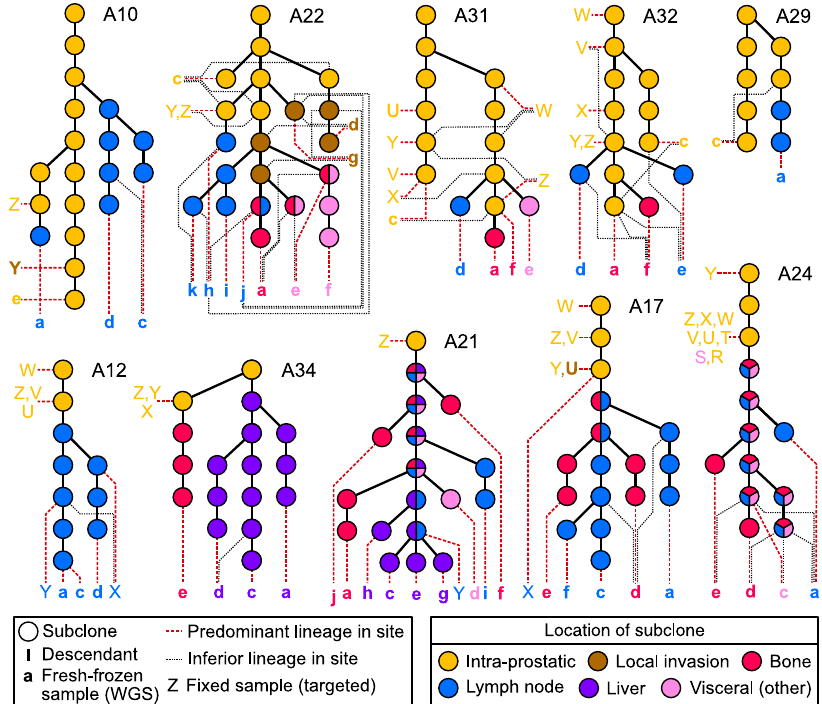
Fig. 1 Phylogenetic trees of primary and metastatic prostate cancer evolution in ten men. Top row — patients who still had prostate in place at time of death; bottom row — patients who had undergone radical prostatectomy (A12, A17, A21, A24) or had no discernible cancer in the prostate at time of death (A34). Patient identi fi ers are to the right of the root node of each tree, which represents the most recent common ancestor (MRCA) of all tumor cells. Dotted lines connect the fi nal subclone of a lineage with a letter denoting the sample or samples in which it was observed. Samples connected to multiple lines arising from different subclones indicates subclonal intermixture in the prostate and local organs, or polyclonal seeding in the periphery. Yellow fi lled subclones were observed in samples taken from the prostate. Other colors denote the location of sample in which the subclone was observed as indicated in the key, where subclones consisting of multiple colors indicate that the subclone was not found in the prostate, but was observed in the metastatic locations with corresponding colors. Fresh frozen samples are denoted by bold lower case letters in ascending order from a; microdissected fi xed samples are standard upper case in descending order from Z. Letters are colored by sample tissue type. Samples taken from the prostate and local organs are arranged to the left or right of each tree. Samples taken from distant metastases are arranged horizontally at the bottom of each tree. Visceral (other) includes adrenal glands (A21, A22, A31), diaphragm (A24), and sigmoid colon (A24). Corresponding sample names, time of collection, cluster information and locations are given in Supplementary Figs. 1 – 10 and Supplementary Data 1 and 2.